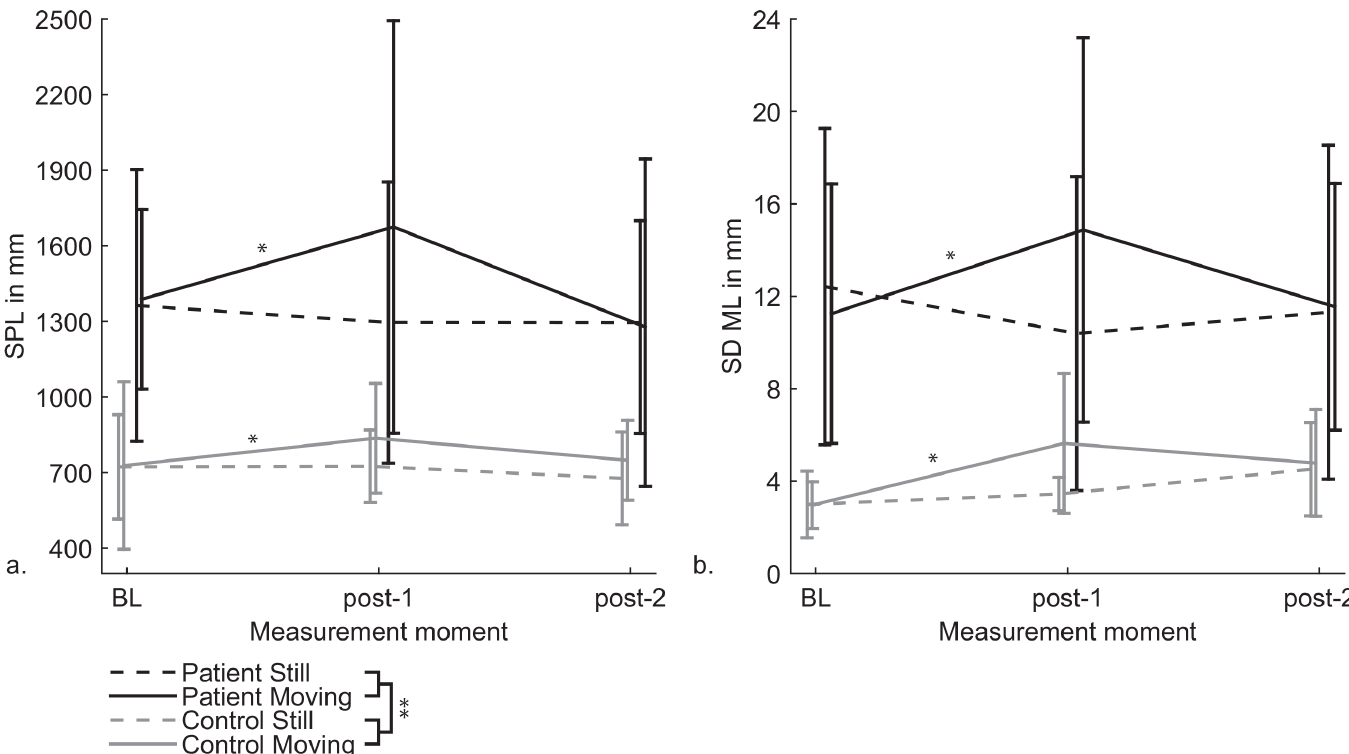
Fig 3. a. The sway path length (SPL) in mm ( ± SEM) and b. Standard deviation in mediolateral direction (SDML) in mm ( ± SEM) for both groups and sessions. VVM patients always exhibited a higher SPL and SDML than healthy controls. Both VVM patients and controls had a higher SPL and SDML due to exposure to optokinetic stimulation compared to eyes open. Significant differences at p < . 05 are indicated with *